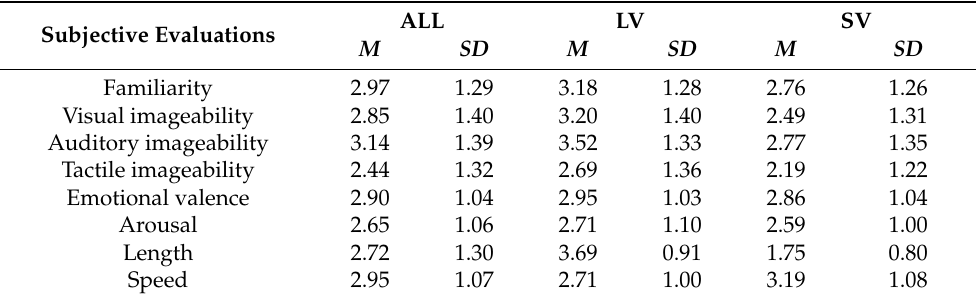
Table 1. Descriptive statistics for written Japanese sound-symbolic words including long vowels (LV) and short vowels